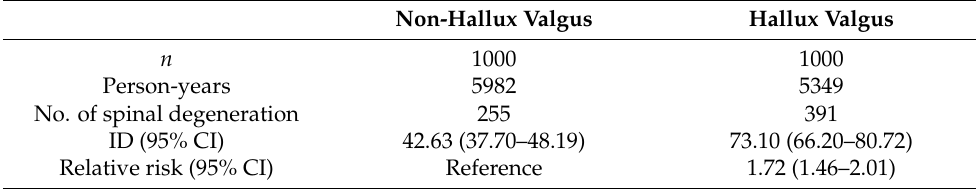
ID, incidence density (per 1000 person-years); CI, confidence